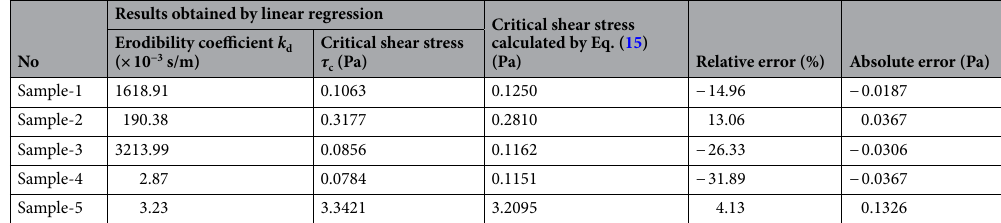
Table 5. Erodibility coefficient and critical shear stress obtained by linear regression and comparison between the fitting critical shear stress values and the calculation results from Eq. (15).